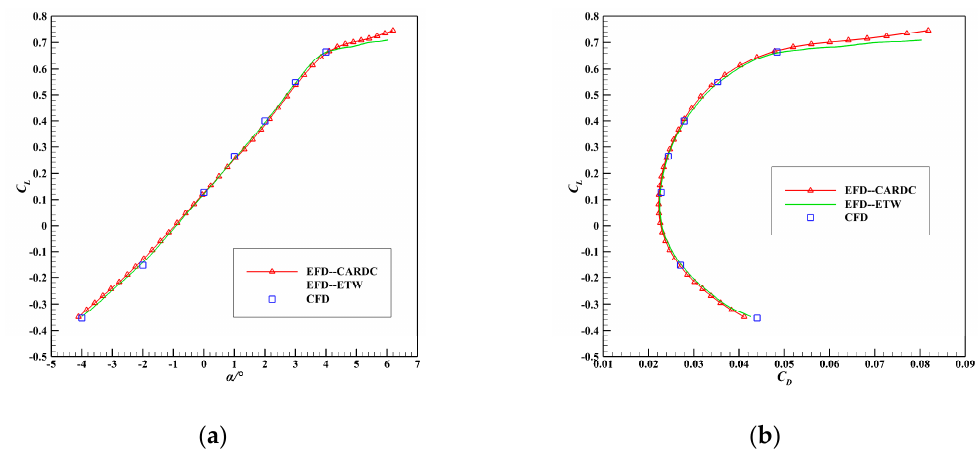
Figure 4. Computational fluid dynamics (CFD) and European Transonic Windtunnel (ETW) / China